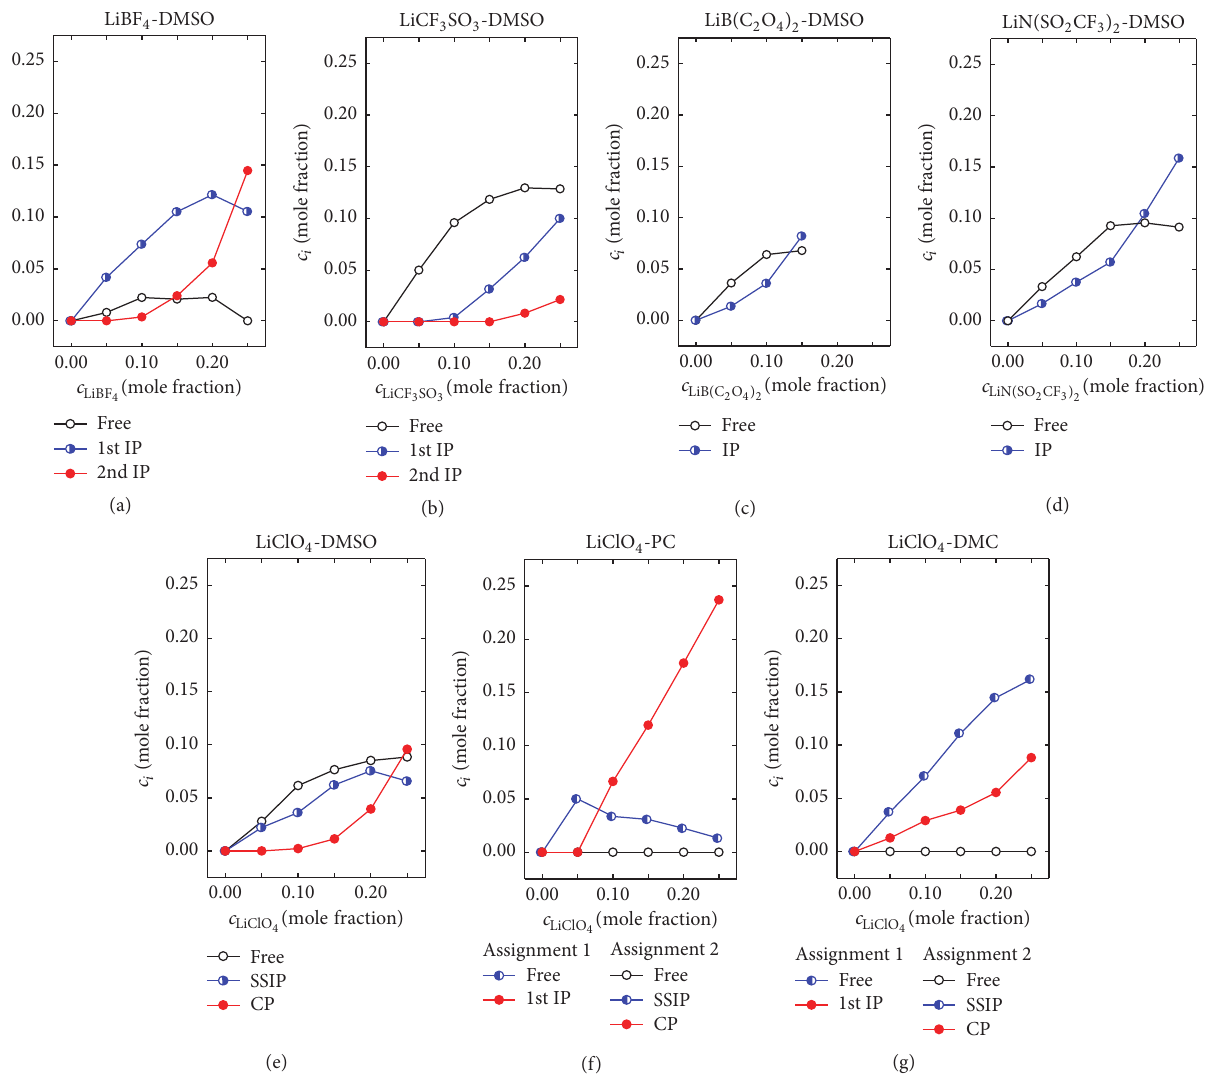
Figure 7: Concentrations of free anions and ion pairs in solutions of DMSO, PC, and